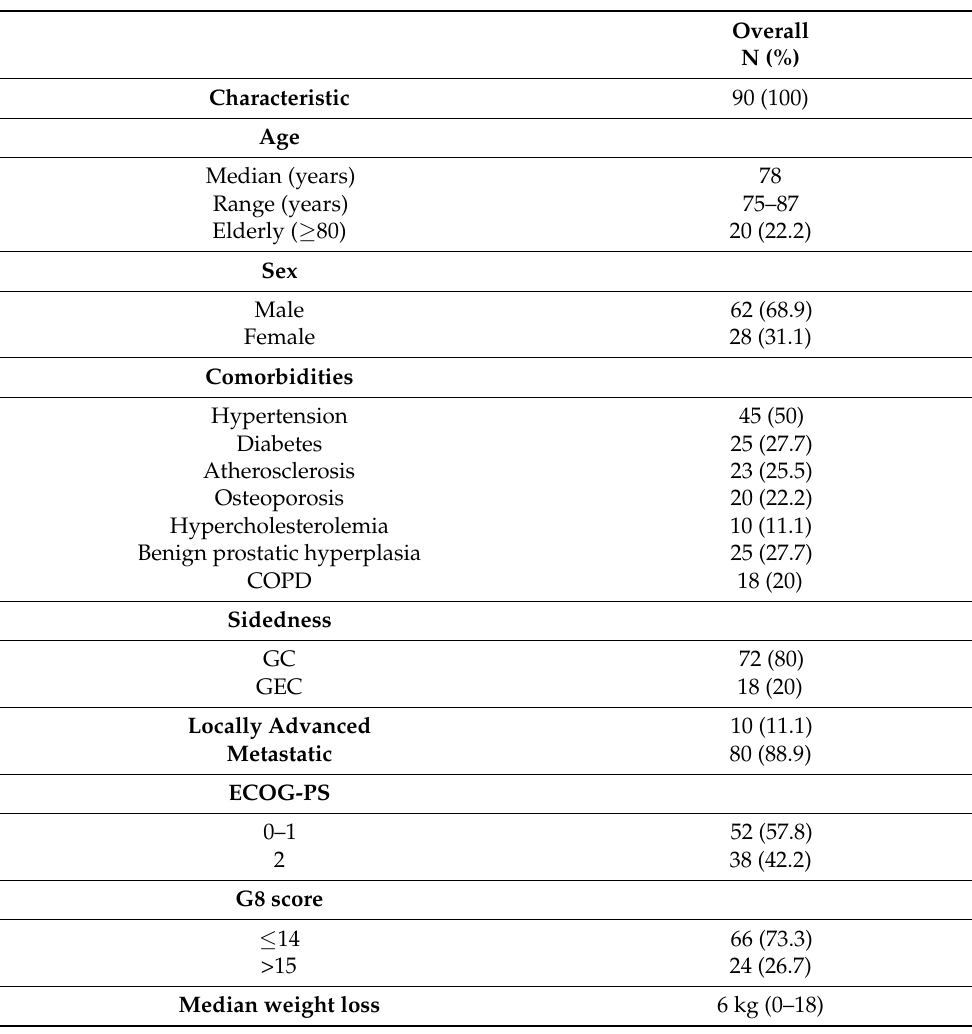
Table 1. Patient